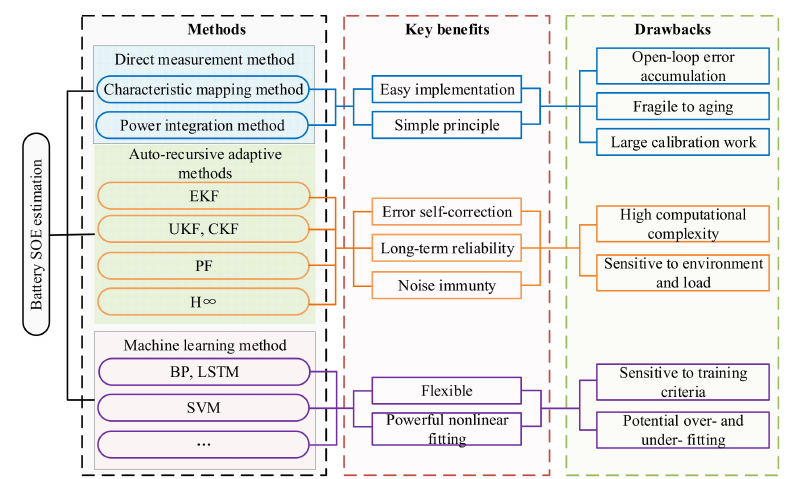
Figure 1. SOE prediction methods in terms of key benefits and